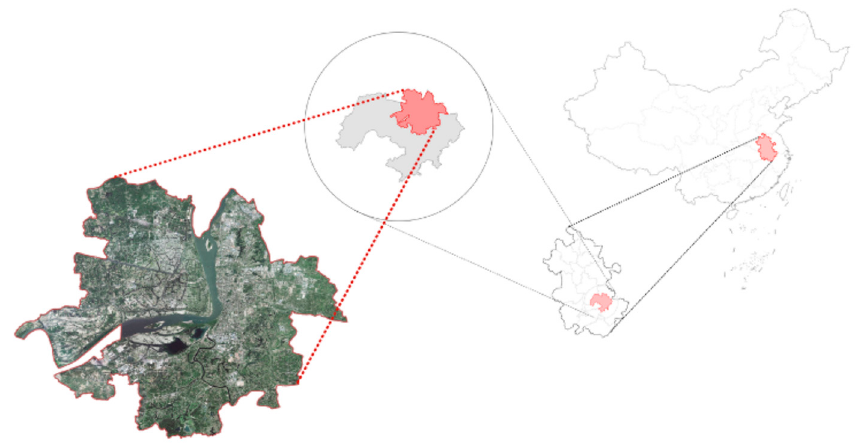
Figure 2. Location of the study area in Anhui province, China and its boundary. Source: own study using the map data from the Ministry of Natural Resources Standard Map Service System [44].